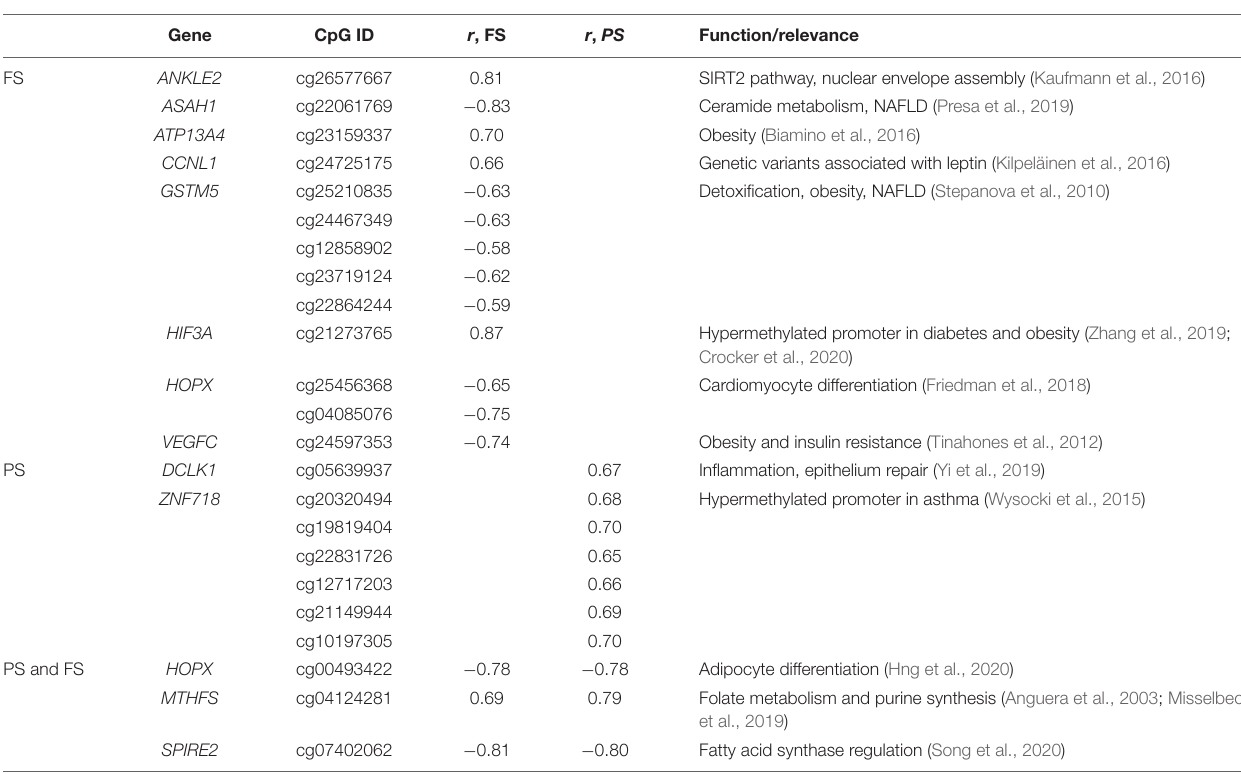
TABLE 1 | Selected relevant promoter